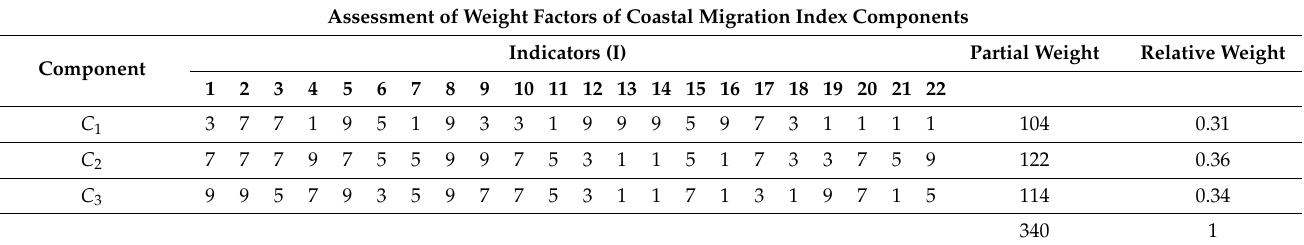
Table A1. Assessment of coefficients n 1 , n 2 and n 3 of the C i components of the CMI in Case A: Tamaulipas, Mexico. Assessment of Weight Factors of Coastal Migration Index Components Indicators (I) Partial Component